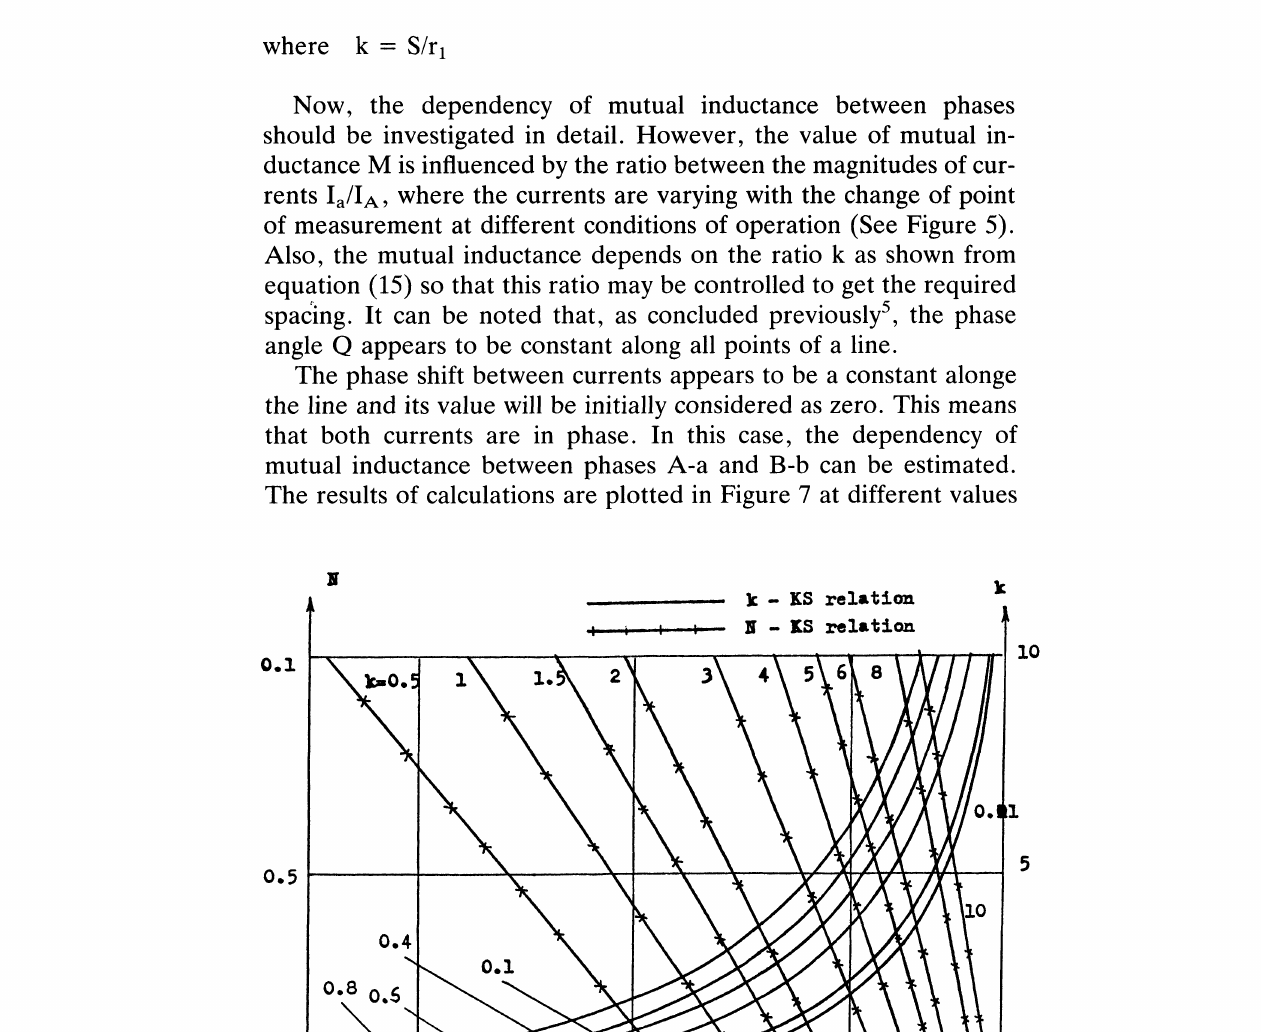
FIGURE 7 The calculated values of coefficient (KS) at zero